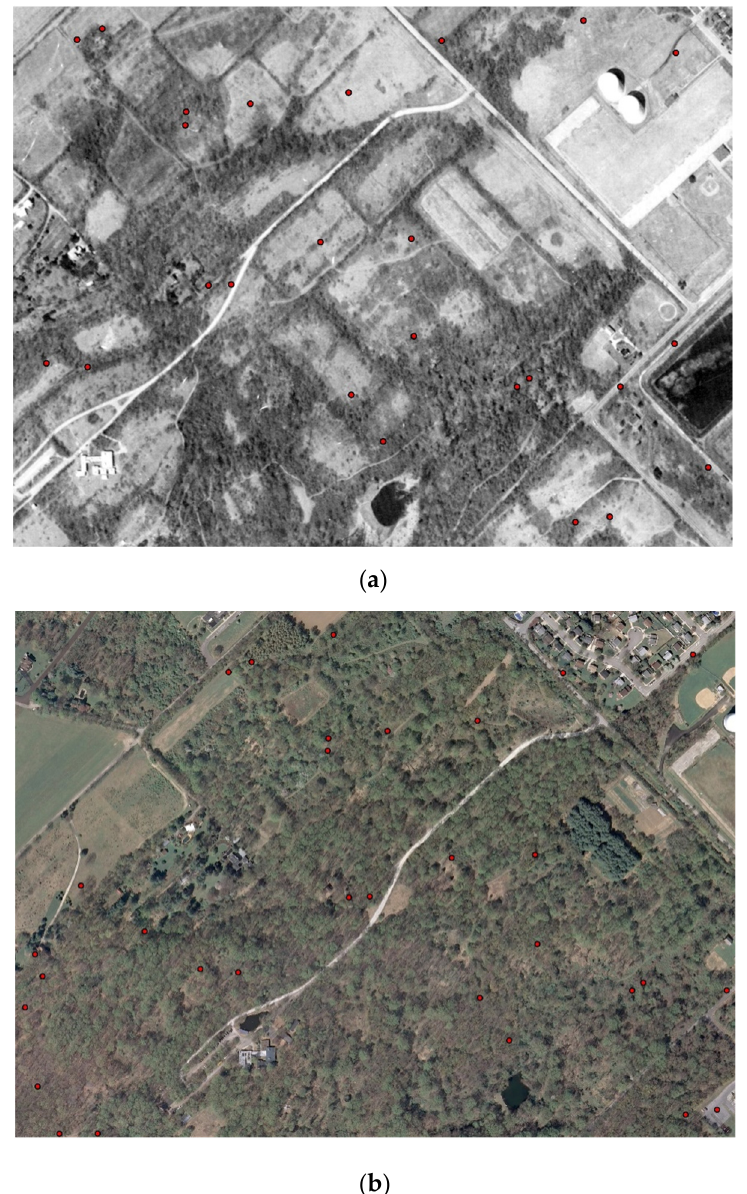
Figure 5. Aerial imagery from ( a ) 1970 and ( b ) 2010 for Schuylkill Center. These images illustrate an area where herbaceous cover in former agricultural fields was replaced with tree cover. Red dots are points that were interpreted for land cover.